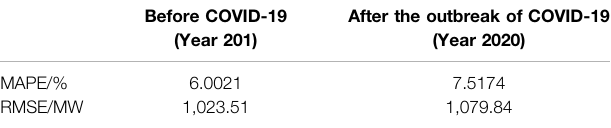
TABLE 3 | Forecasting performance of ResGCN with naive load graph.